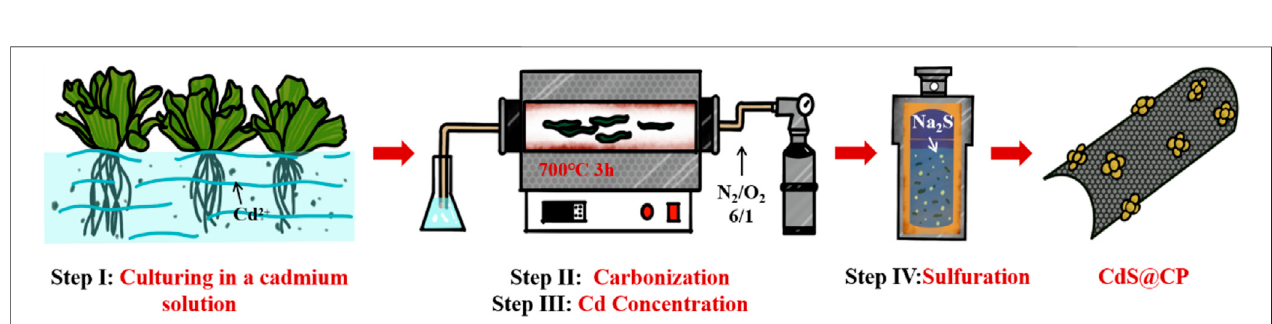
SCHEME 1 | Schematic illustration of the procedures for CdS@CP photocatalyst composites.